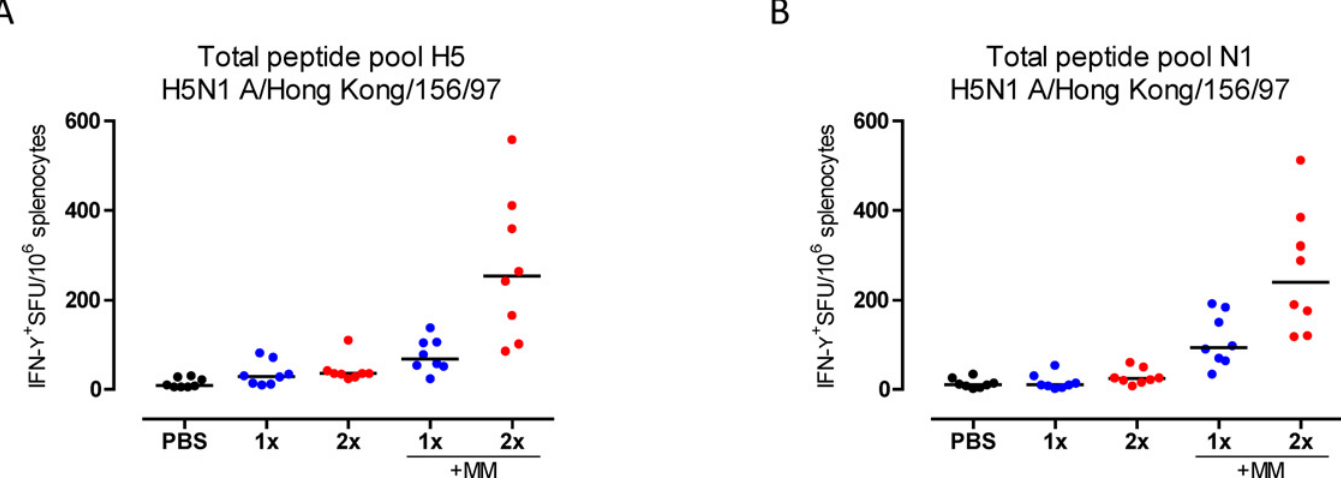
Fig 3. H5 and N1 cross-reactive T cells are induced by TVV+MM. Mice (n = 8/group) were immunized once or twice with TVV or TVV+MM. Three weeks later, spleens were harvested. The number of IFN- γ producing T cells was determined by ex vivo stimulation of splenocytes with peptide pools consisting of 15-mer peptides that cover the total (A) HA or (B) NA sequence of H5/HK with an 11-mer overlap. Black bars indicate medians of IFN- γ + T cells per 10 6 splenocytes. SFU = Spot forming